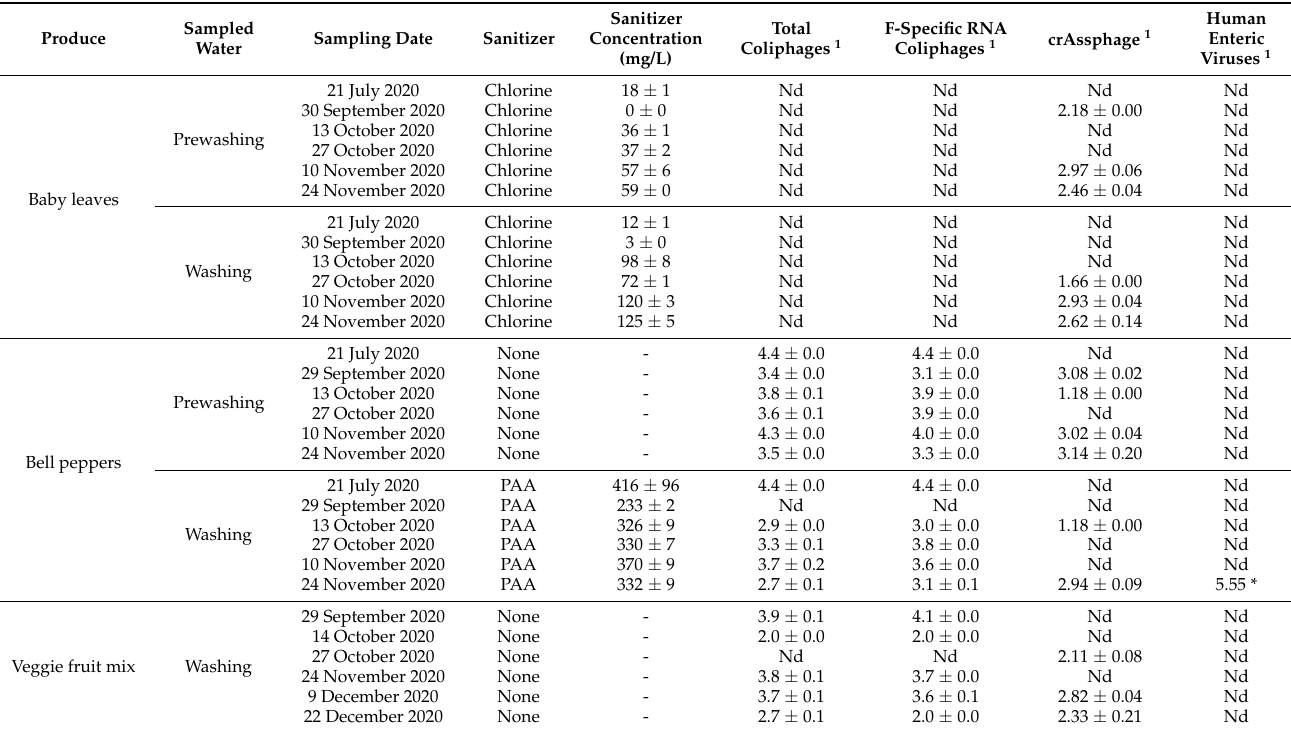
Table 2. Levels of total and F-specific RNA coliphages, crAssphage, and human enteric viruses (norovirus GI and GII, HAV, HAstV, RV) of wash water from the prewashing and washing steps of baby leaves, bell pepper, and veggie fruit mix of commercial lines using sodium hypochlorite, peracetic acid (PAA) and without sanitizer, respectively. Produce Sampled